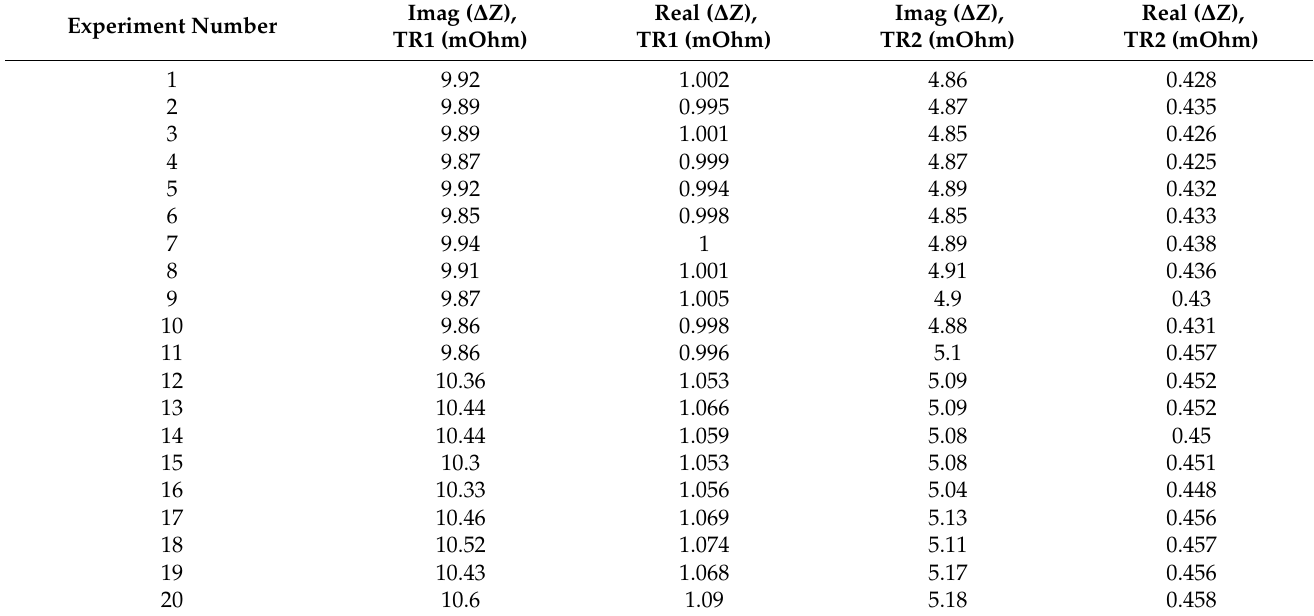
Table A2. Raw data of impedance change, spherical aluminum metal at a lift-off of 3 mm.